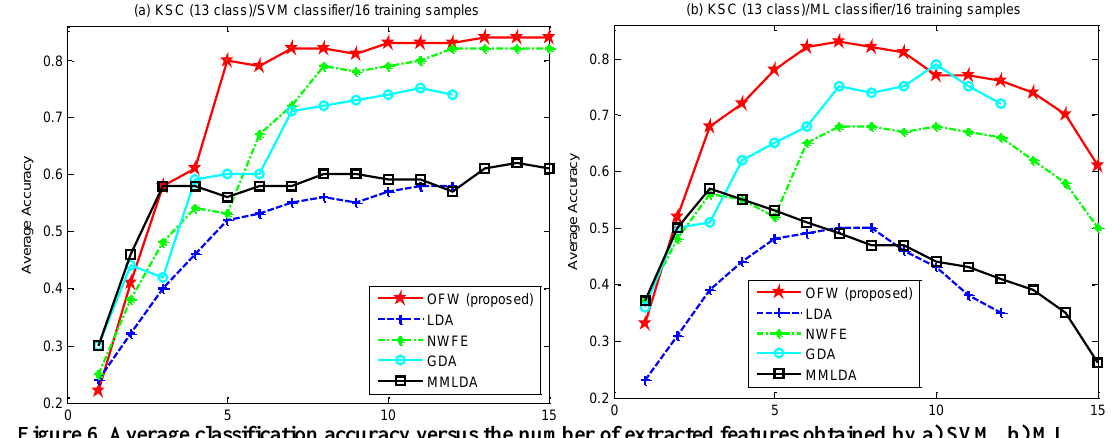
Figure 6. Average classification accuracy versus the number of extracted features obtained by a) SVM, b) ML classifiers for KSC dataset. Table 1. Accuracy and reliability of classes of Indian dataset obtained by SVM classifier and 9 extracted features.